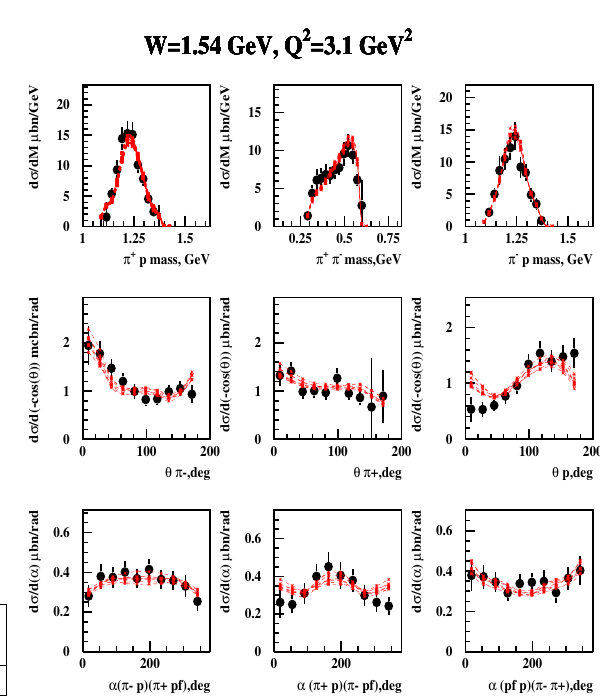
Figure 2. (Color online) Data for π + π − p electroproduction [19] (black filled circles with error bars) and di ff erential cross sections computed (red lines) within the updated JM model (see Section 2) at 1.53 GeV < W < 1.55 GeV and 3.0 GeV 2 < Q 2 < 3.5 GeV 2